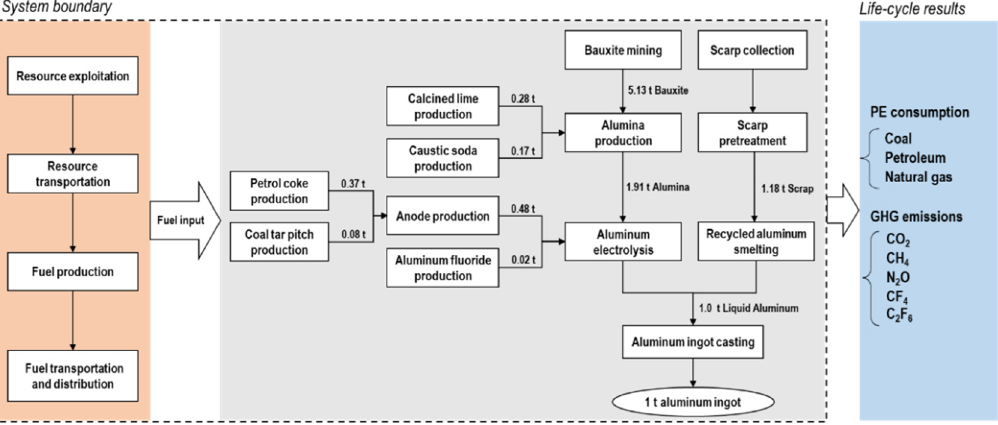
Figure 1. System boundary and material flow of primary and recycled aluminum production in China.